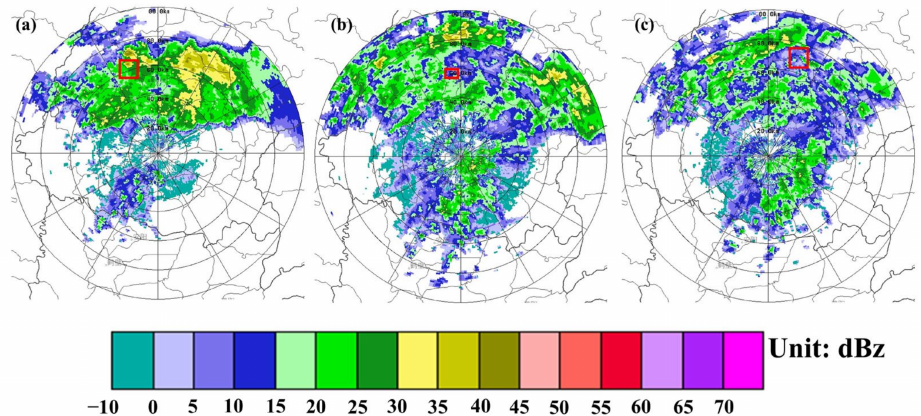
Figure 4. 21 May 2018 ( a ) 13:18, 2.4 ◦ elevation angle PPI, ( b ) 14:18, 2.4 ◦ elevation angle PPI, ( c ) 14:36, 3.4 ◦ elevation angle PPI. The red rectangle box is the aircraft detection area.